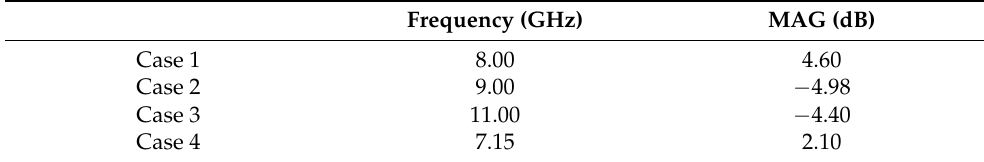
Table 4. Measured maximum available gain